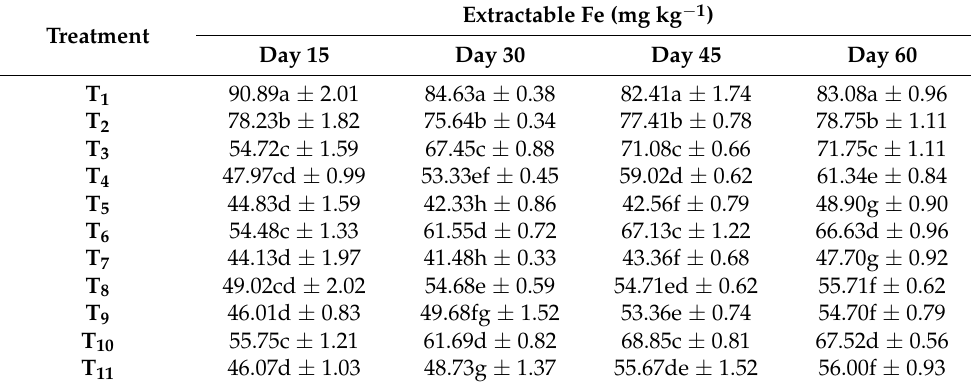
Table 12. Effect of RHB, EFBB, and dolomitic limestone treatments on soil extractable Fe.